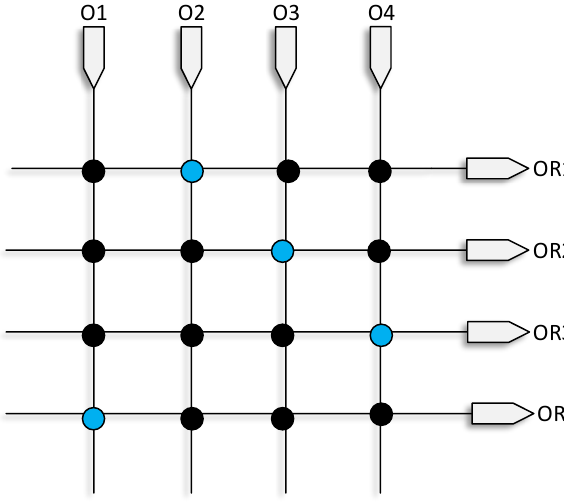
Figure 11. Connection box (CB2) internal architecture.